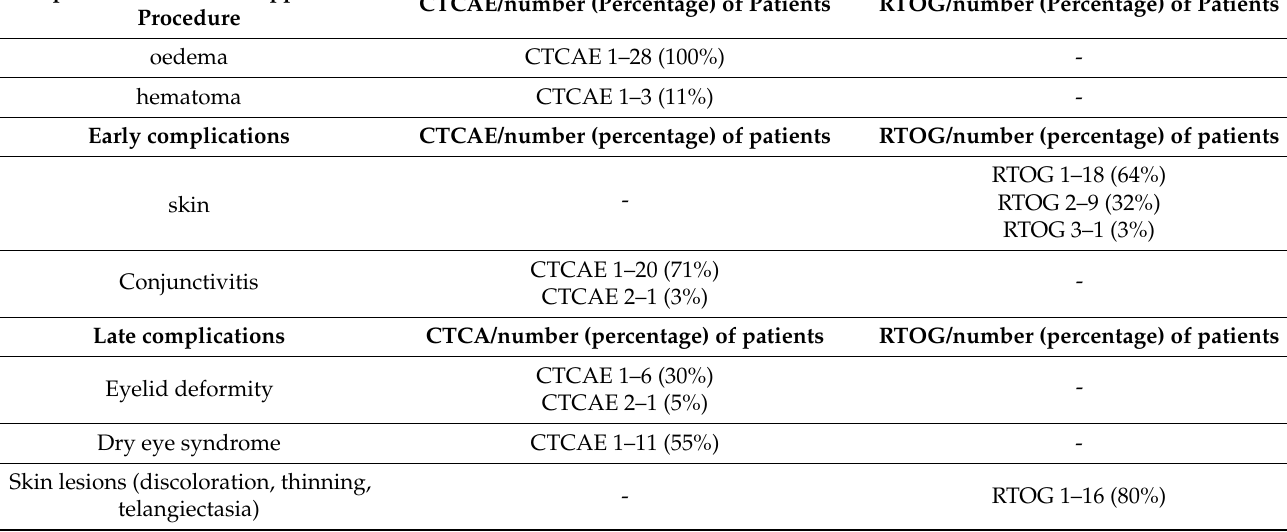
Table 4. Characteristics of early and late toxicity of radiation therapy and application procedure. CTCAE—Common Terminology Criteria for Adverse Events; RTOG—Toxicity criteria of the Radiation Therapy Oncology